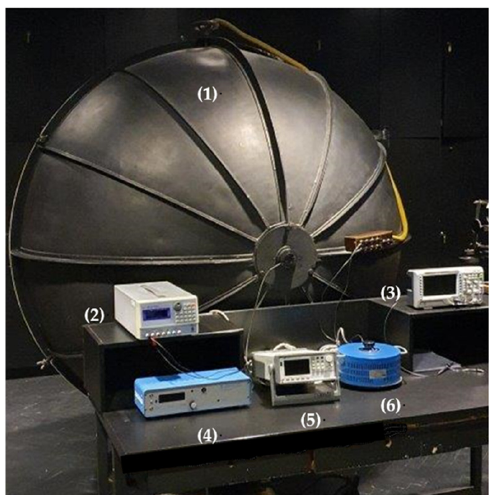
Figure 6. Luminaire light curve LED_26W.